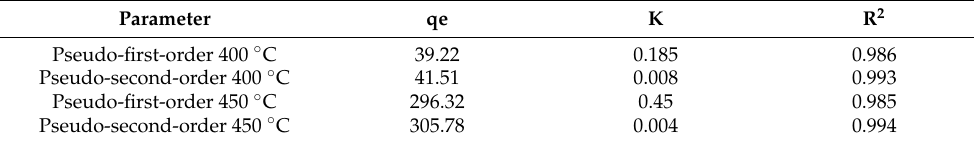
Table 8. Parametersofpseudo-first-orderandpseudo-second-orderkineticmodelsforbiocharimpregnated.